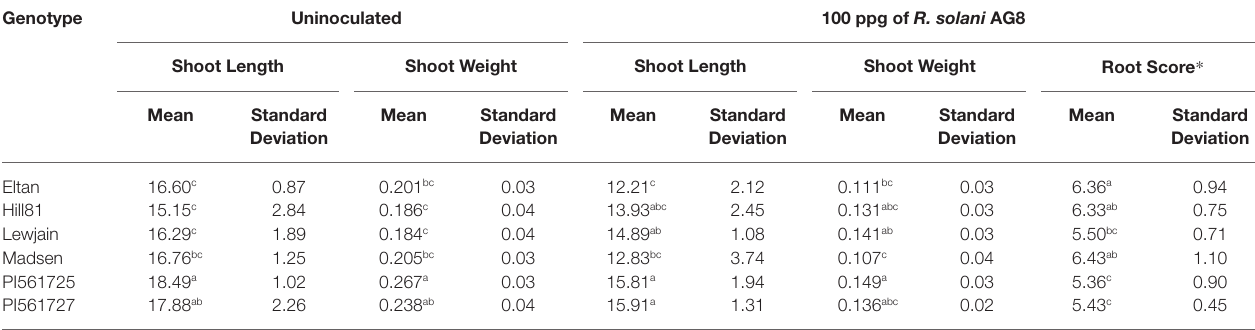
TABLE 1 | Summary of the suppression assay after the third cycle of the 160-day growth cycle.